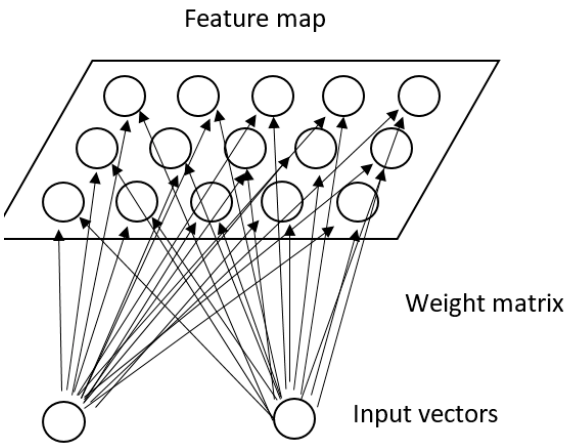
Figure 6. An example of SOM.